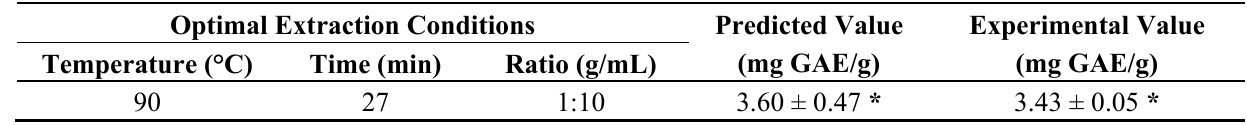
Table 3. Validation of TPC yield under optimal extraction conditions predicted by Response Surface Methodology